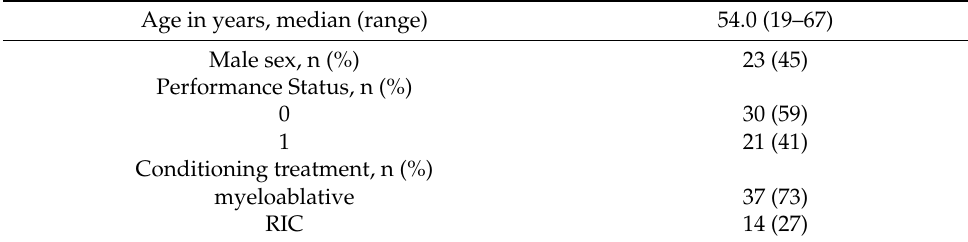
Table 4. Patients characteristics (n =